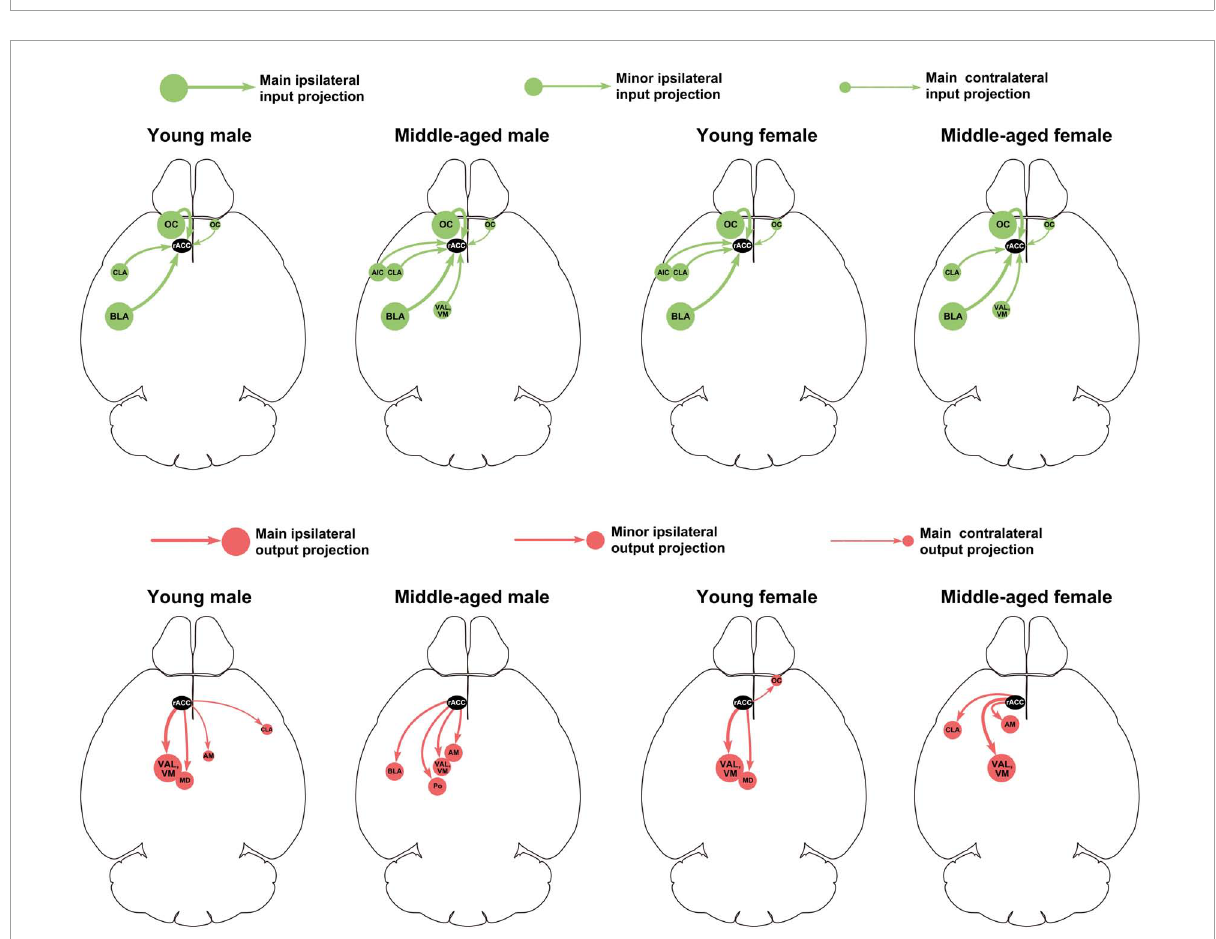
FIGURE8 Summary of main and minor input-output projection circuits of the rACC in the bilateral brain of mice of different ages and